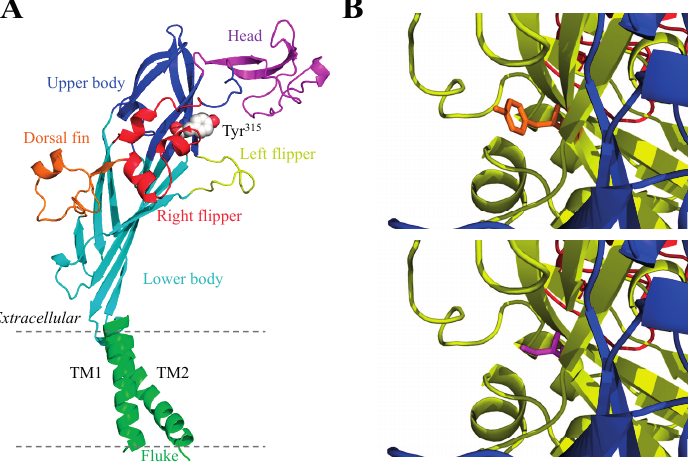
Figure 3. Structural homology models of the human P2X4 receptor. ( A ) the dolphin-shaped structure of a single receptor subunit in the closed state shown with distinctive body parts in different colours (the same colour scheme used in Figure 2A for the human P2X2 receptor subunit) and the location of Tyr 315 highlighted; and ( B ) views of Tyr 315 (orange; top ) and Cys 315 (magenta, bottom ) in the close proximity to the ATP-binding site in the open